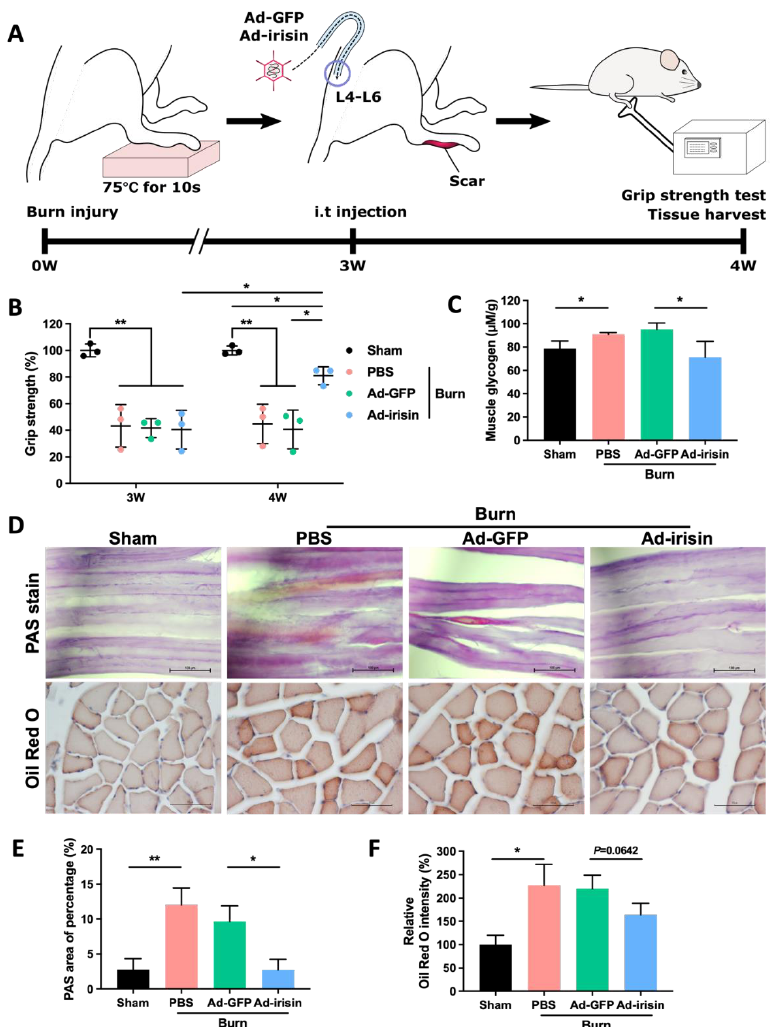
Figure 1. Spinal irisin gene delivery rehabilitated burn injury-induced muscle weakness and atten- uated metabolic derangement. ( A ) Full-thickness burn injury was induced on the right hind paws of rats on a heated metal block (75 °C ± 0.5 °C) for 10 s. Silver sulfadiazine cream was applied to their paws every day for 3 weeks until their wounds closed completely. Intrathecal (i.t.) administration of Ad-GFP and Ad-irisin (1 × 108 c.f.u.) was performed in the third week after burn induction. Grip strength was measured at the third week, right before the i.t. injection, and in the fourth week, as a post-injection, for 1 week. Tissues were harvested for further analyses. ( B ) Representative scatterplot illustrating the ratio of the related ipsilateral to contralateral hindlimb grip strength after burn induction in the third and fourth weeks. These ratios were compared with those of a sham group at each time point. Error bars represent standard deviations (SDs). * p < 0.05, ** p < 0.01, unpaired t -test. ( C ) Representative bar graph of glycogen levels in ipsilateral gastrocnemius muscle detected using a glycogen detection kit (Abcam, Boston, MA, USA) in the fourth week after burn injury. Error bars represent SDs. * p < 0.05, ** p < 0.01, unpaired t test. ( D ) PAS and Oil Red O staining of ipsilateral gastrocnemius muscle in the fourth week after burn injury. ( E ) Representative bar graph illustrating percentage of PAS-positive area. Error bars represent SDs. * p < 0.05, ** p < 0.01, unpaired t test. ( F ) Representative bar graph illustrating relative intensity of Oil Red O staining. Error bars represent SDs. * p < 0.05, unpaired t